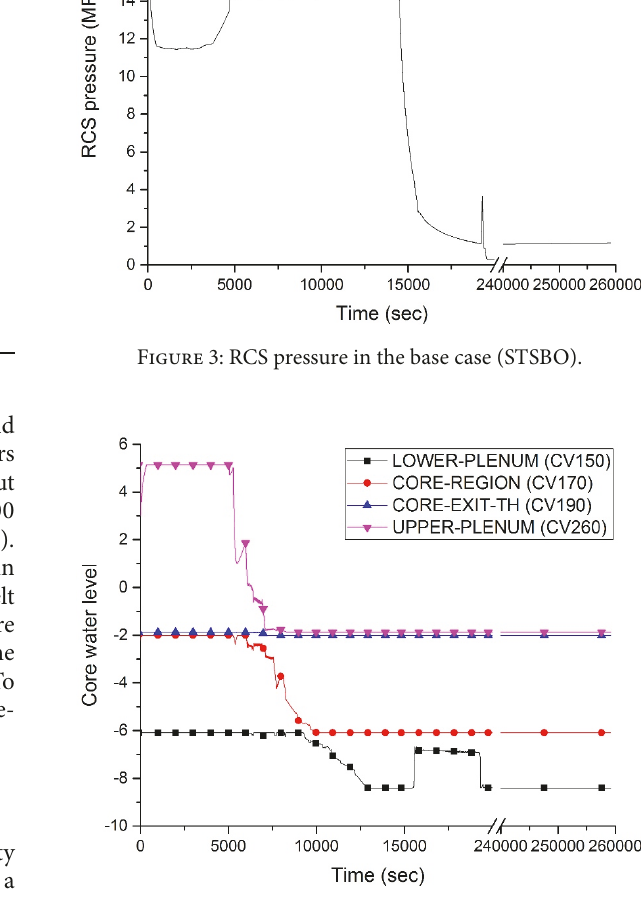
Figure 4: Core water level in the base case